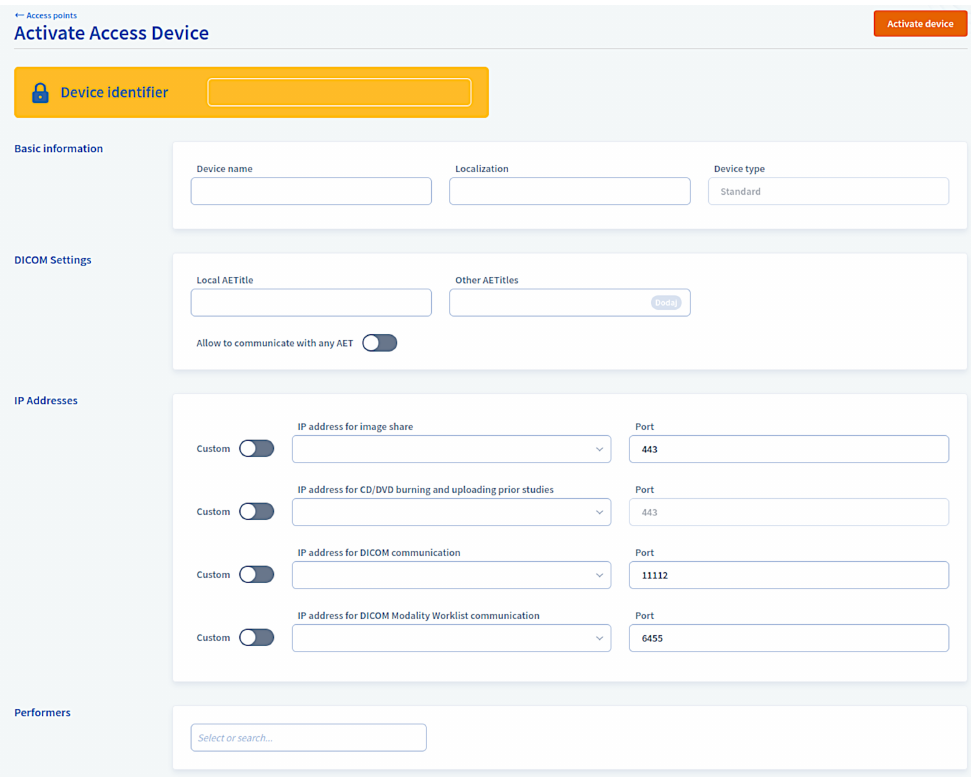
Figure 5. Access device